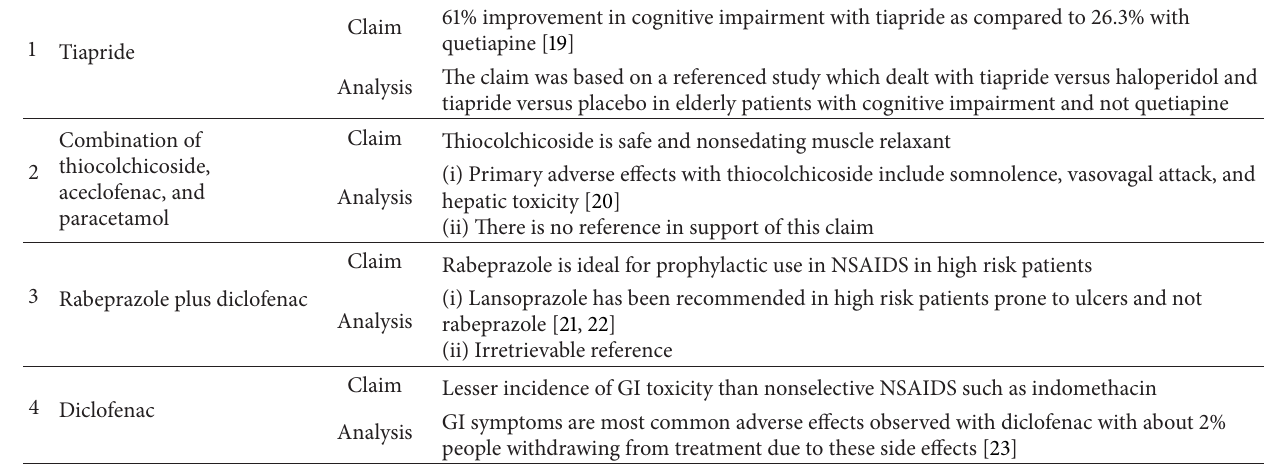
Table 1: Examples of false claims made in drug advertisements.